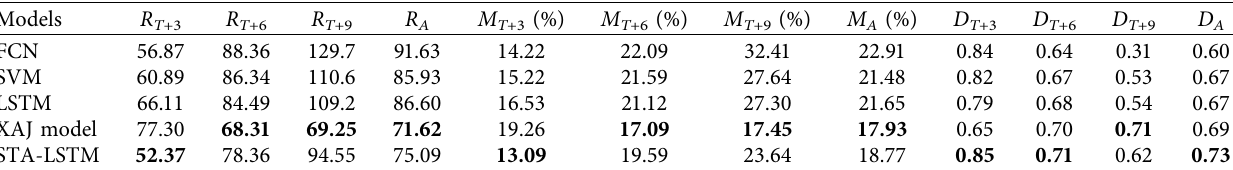
Table 5: Comparisons on Changhua dataset with several comparative methods. Note that bold texts indicate best performance among comparative